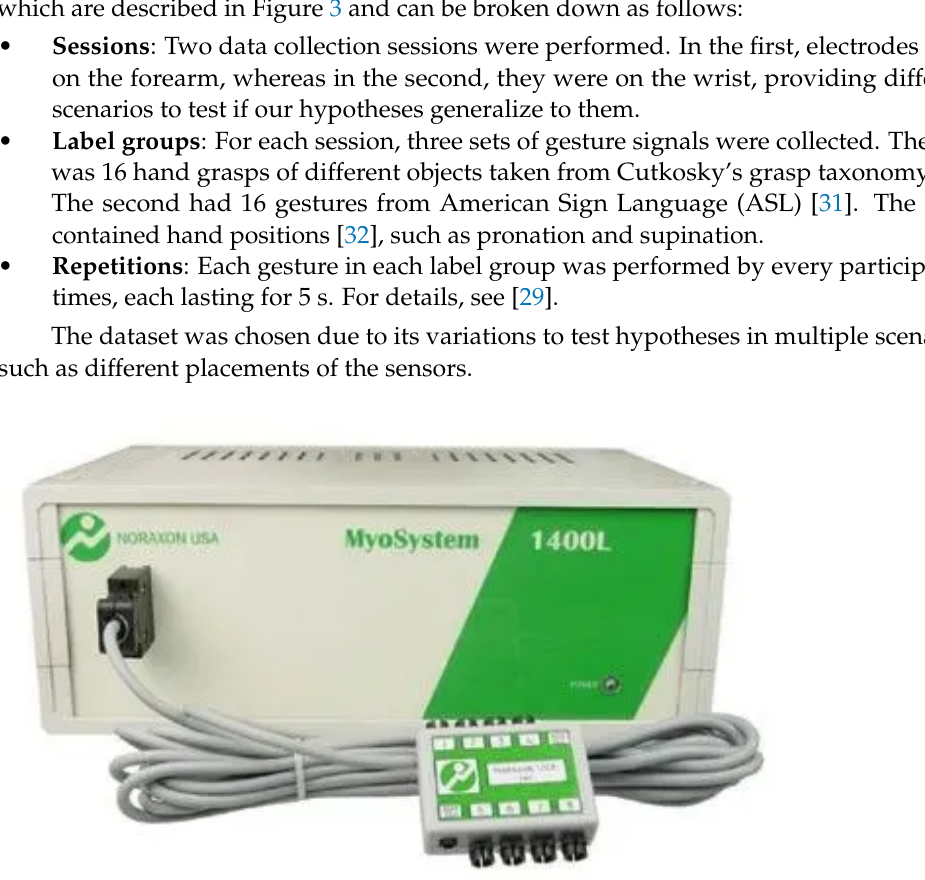
Figure 1. The MyoSystem 1400L sEMG data acquisition